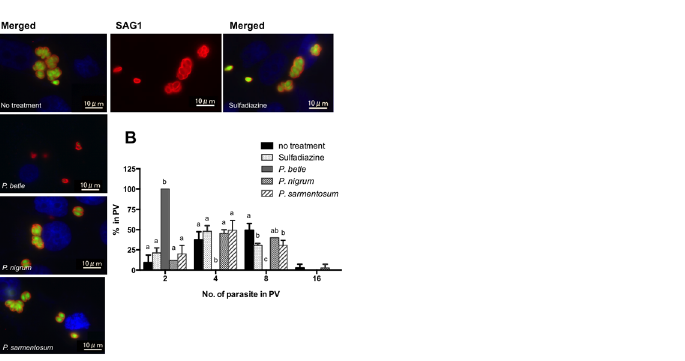
Fig 3. Effects of the three piperaceae extracts at 25 μ g/mL and sulfadiazine at 1 mg/mL on intracellular T . gondii . The RH-GFP-infected vero cells were treated with either of the three piperaceae extracts or sulfadiazine for 72 h, and were then analyzed by IFAT to measure the parasitophorous vacuole (PV) sizes. (A) Representative images of T . gondii RH-GFP-infected vero cells. The cells were treated with either P . betle (25 μ g/mL), P . nigrum (25 μ g/mL), P . sarmentosum (25 μ g/mL) extract, or sulfadiazine (1 mg/mL). SAG1, red; GFP, green; nucleus, blue. (B) The number of parasites in PVs was measured by counting the number of SAG1-positive parasites per PV. Each bar represents the mean ± SD of three wells per group. Results represent two independent experiments. The different letters above the data bars in the graphs indicate statistically significant differences in the number of parasites in PVs as determined by two-way ANOVA plus Tukey – Kramer post-hoc analysis ( P < 0.05).